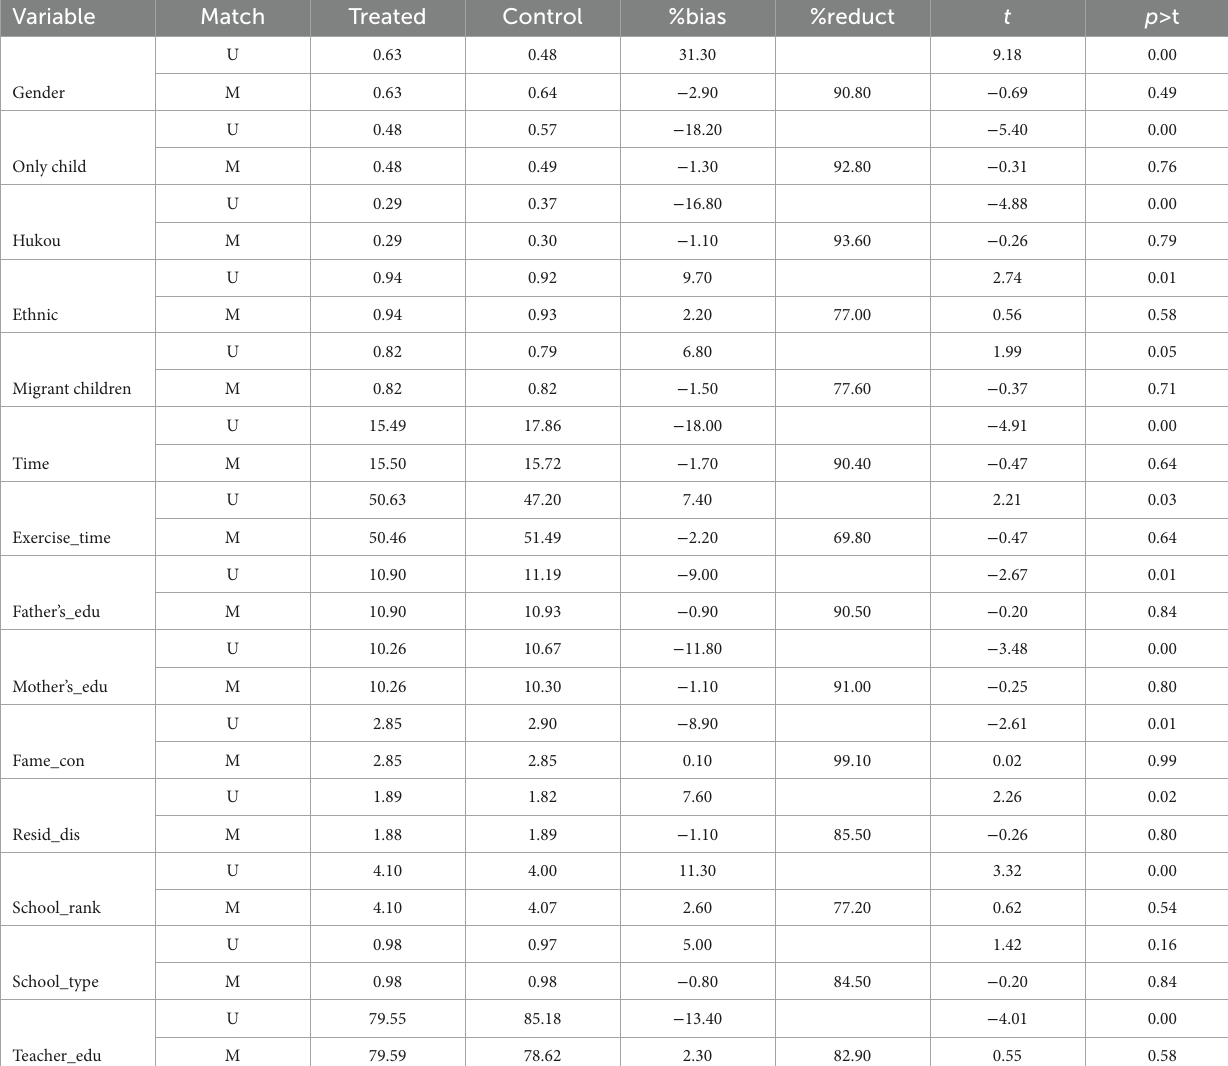
TABLE 4 Parallel hypothesis in estimating the ATT of bicycling to school on the health.